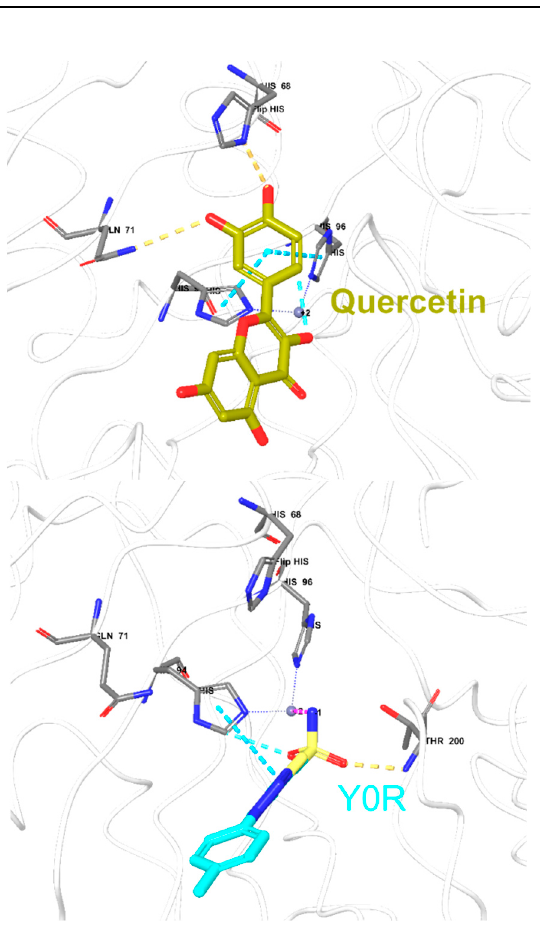
Figure 9. Docking poses for metabolite 11 ( M11 ) and Y0R into CA IX crystal structure.